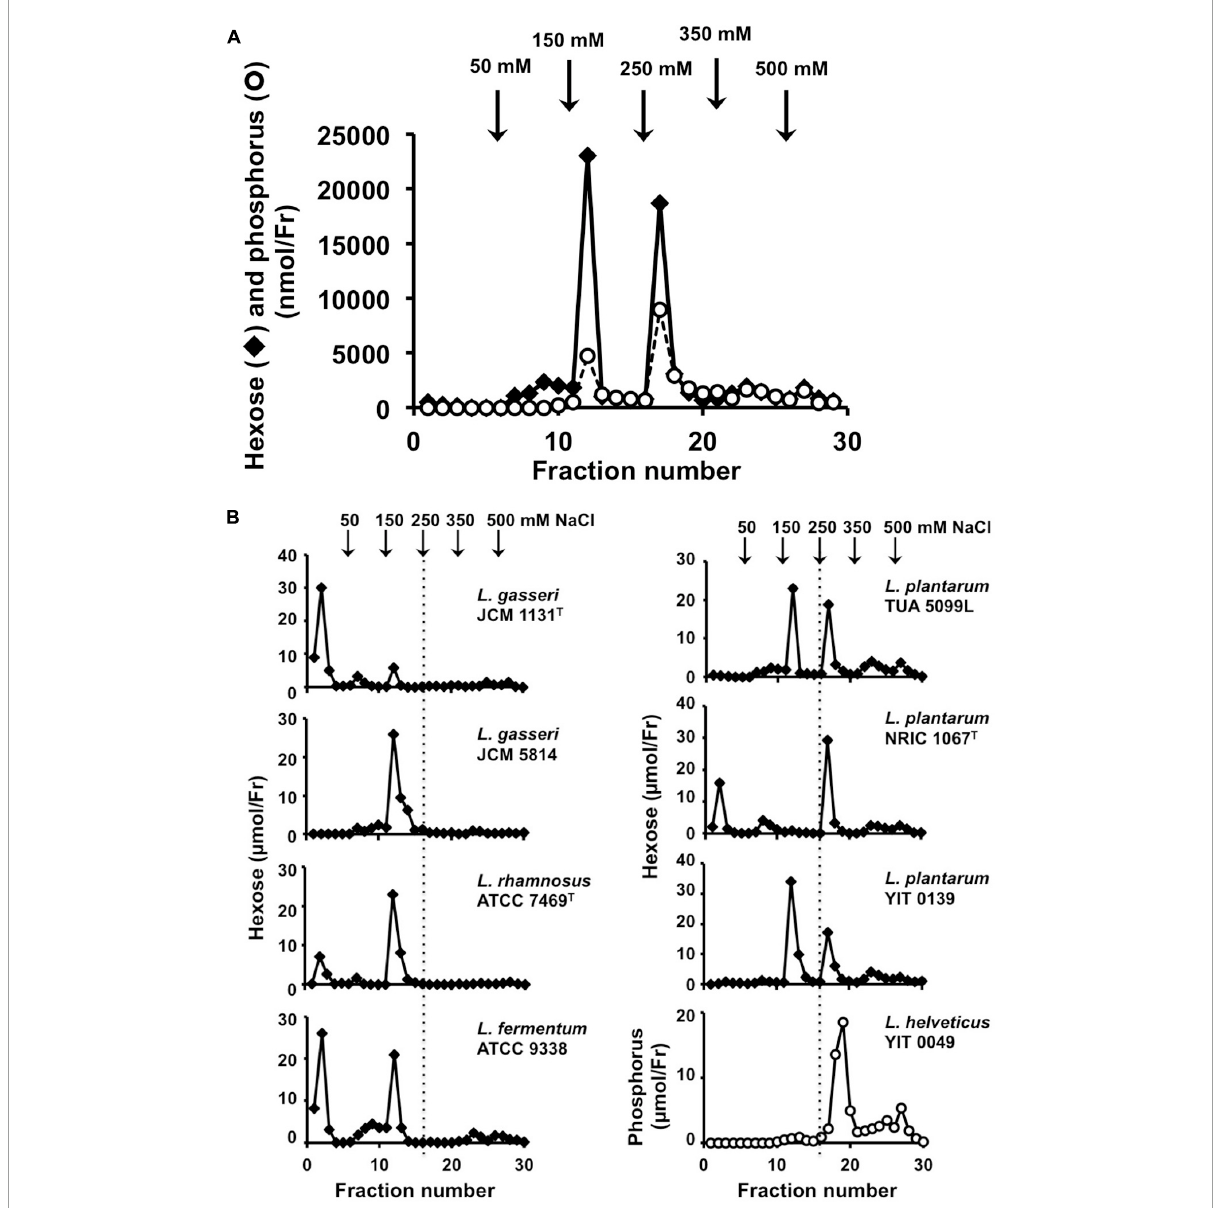
FIGURE3 Analysis of cell wall glycopolymers isolated from N -acetylated ICWs of lactobacilli. (A) ICWs of L. plantarum TUA 5099L were N -acetylated and treated with 0.1 M glycine-HCl, pH 2.5 at 100 ◦ C for 30 min. After centrifugation at 8,000 × g for 15 min, supernatants were recovered, dialyzed against 5 mM Tris–HCl (pH 7.4), and applied to a DEAE-cellulose column. The column was eluted in a stepwise manner with 5 mM Tris–HCl (pH 7.4) containing 50, 150, 250, 350, and 500 mM NaCl. Fractions (5 ml) were collected and hexoses and phosphorus in each fraction were determined. (B) Chromatography of glycopolymers isolated from N -acetylated ICWs of eight strains of lactobacilli. Glycopolymers isolated from N -acetylated ICWs of each strain were subjected to chromatography on a DEAE-cellulose column, as described above, and hexose or phosphorus was determined. The figure shows representative chromatograms of at least three independent ICW preparations of each strain. Other ICW preparations also gave the same chromatograms. Note that L. plantarum TUA 5099L, NRIC 1067 T , and YIT 0139 and L. helveticus YIT 0049 contain glycopolymers eluted at 250 mM